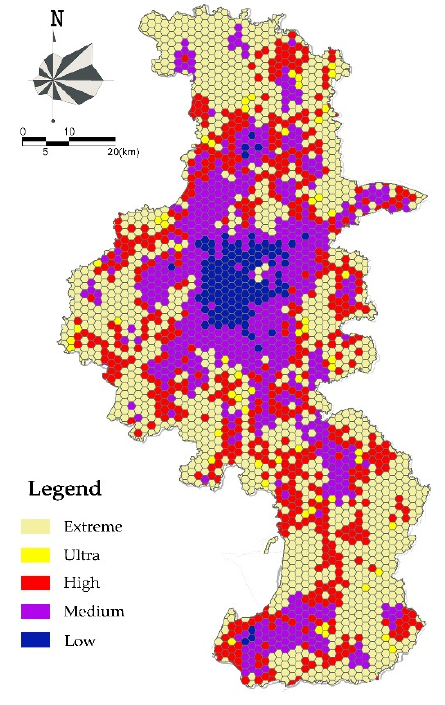
Figure 7. Fire risk